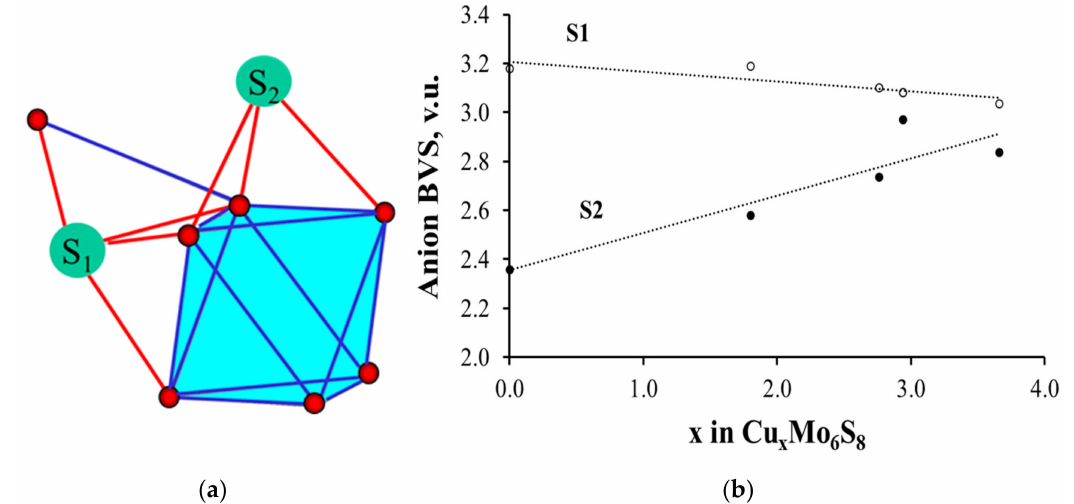
Figure 7. Different coordination of sulfur atoms in Chevrel phase ( a ) and the change of their BVSs in Cu x Mo 6 S 8 ( b